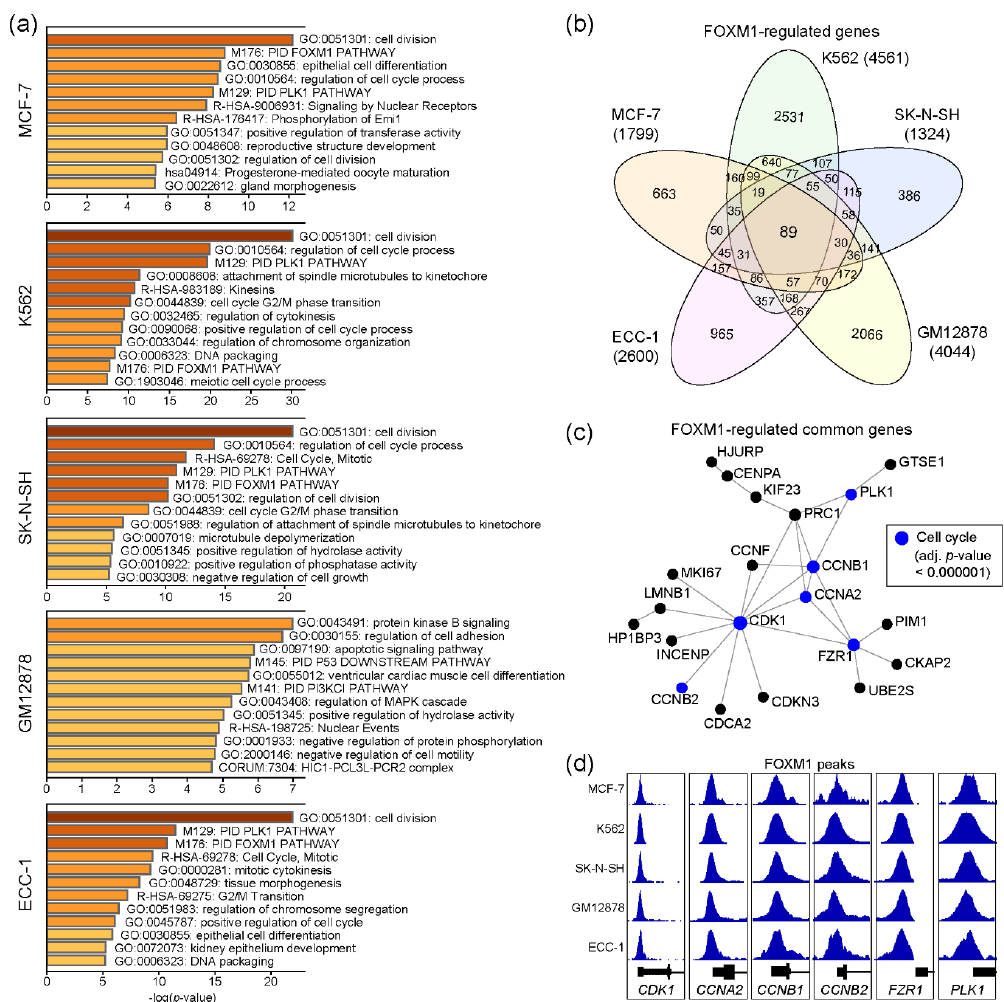
Figure 2. Molecular pathway prediction of FOXM1 target genes. ( a ) Gene ontology (GO) analysis was conducted using Metascape with the top 500 genes (ranked by the height of FOXM1 peaks) around the FOXM1 binding sites. ( b ) A Venn diagram shows the number of FOXM1 target genes identified in five cell lines. ( c ) A protein–protein interaction network was constructed with 89 common FOXM1-target genes among cell lines using NetworkAnalyst. ( d ) FOXM1 binding at promoters of the CDK1, CCNA2, CCNB1, CCNB2, FZR1, and PLK1 genes are shown.